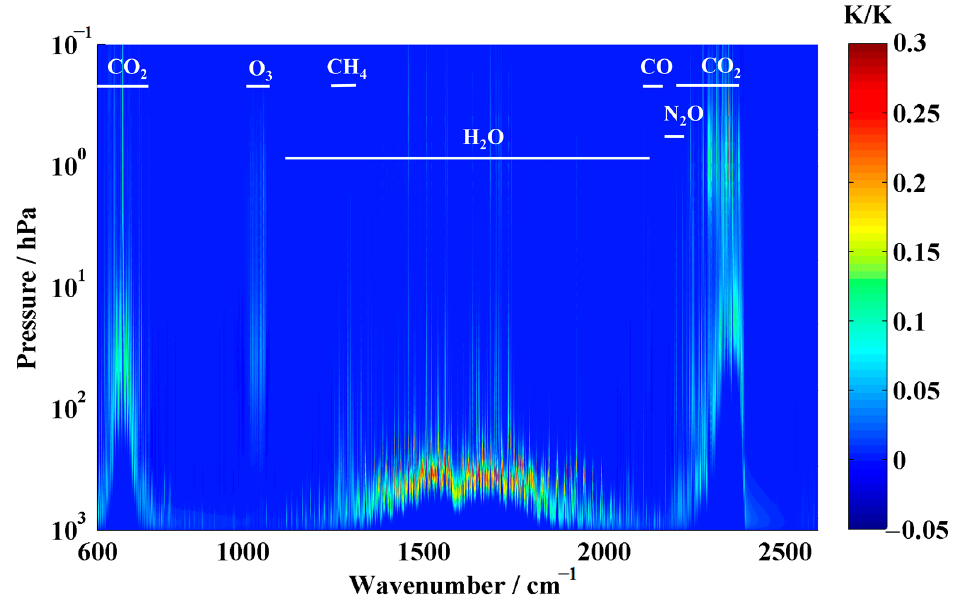
Figure 1. The temperature Jacobians of the infrared spectral region. The calculation is performed by using LBLRTM and US Standard Atmosphere (1976 version).